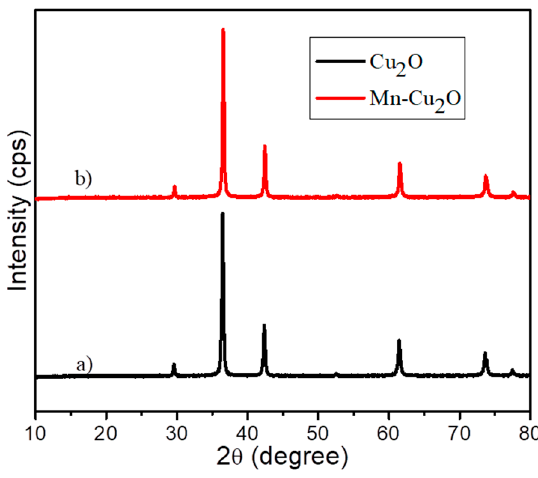
Figure 1. ( a ) XRD pattern of Cu 2 O ( b ) Mn-Cu 2 O nanoparticles. Table 1. Crystalline size of undoped and Mn-doped Cu 2 O nanoparticles.